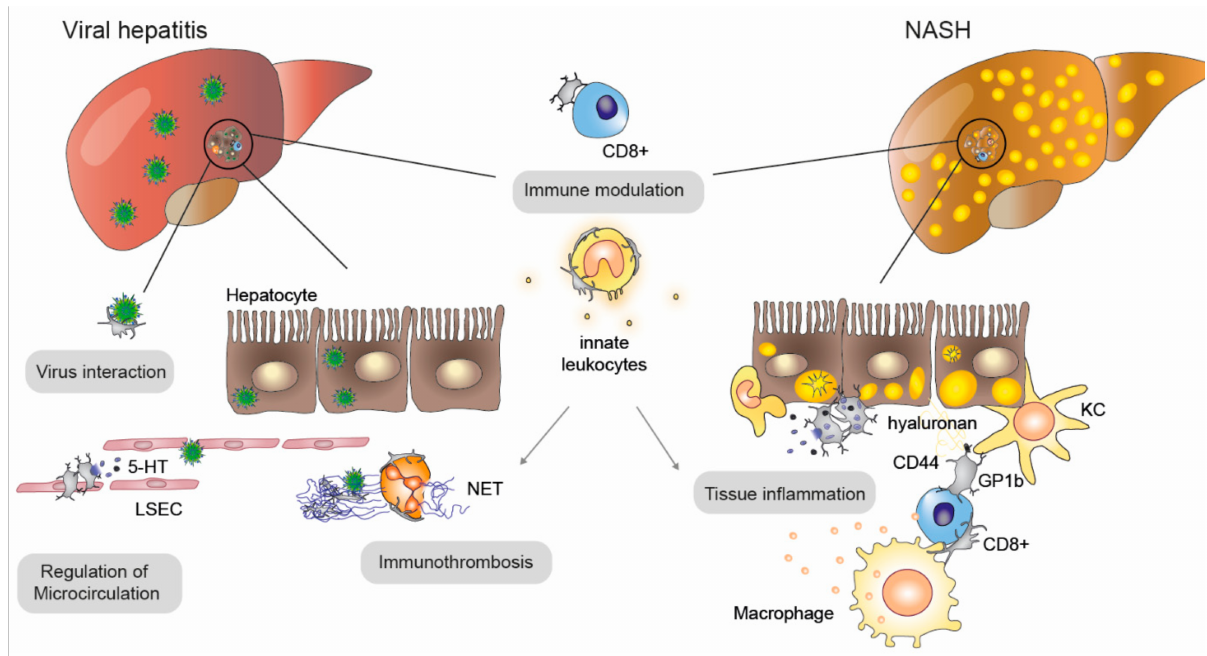
Figure 4. The role of platelets in viral hepatitis and NASH. Platelets become activated in non-alcoholic steatohepatitis (NASH) and viral hepatitis and contribute to disease progression by several mechanisms: recruitment of leukocytes (e.g., CD8+ T cells) via direct and indirect interactions, which fosters immune modulation but also immunothrombosis (e.g., by the promotion of neutrophil extracellular trap (NET) formation by neutrophiles) and tissue inflammation. The interaction of platelets with liver-resident Kupffer cells (KC) is mediated by CD44-hyaluronan as well as von Willebrand Factor (vWF)-GP1b, which is important for immunosurveillance. Platelets directly interact with viruses to either shelter or present them to immune cells. Another important platelet-mediated mechanism is the regulation of local blood flow in liver sinusoids by the release of serotonin (5-HT), which acts on liver sinusoidal endothelial cells